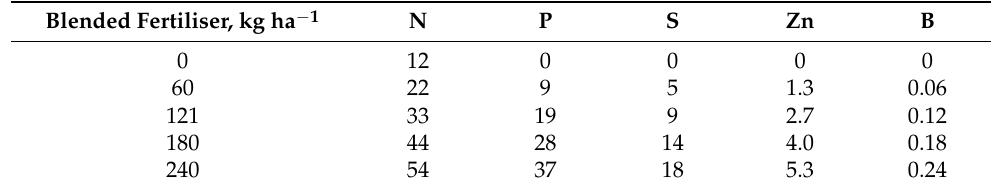
Table 2. Amounts of nutrients, kg ha − 1 , added at different levels in the blended chemical fertiliser and in